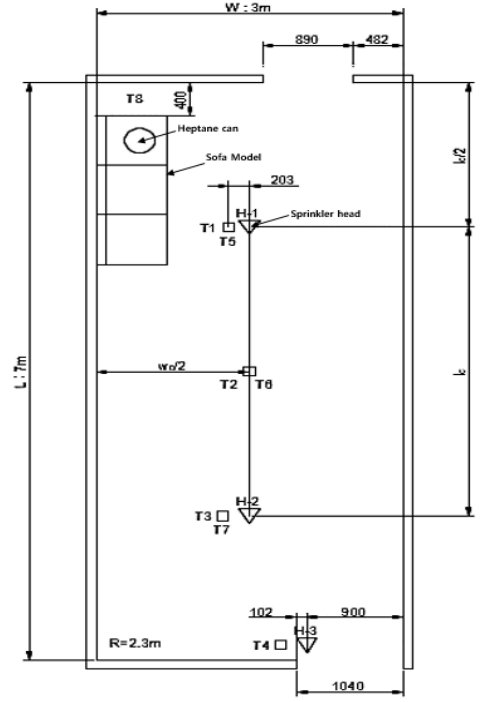
Figure 6. Schematic illustration of the fire test room and the thermocouple location. Note: T1–T4: Thermocouple 76 mm below the ceiling, T5–T7: Thermocouple 1600 mm above the floor, T8: Thermocouple 6 mm above the ceiling and 254 mm diagonally from the corner, H-1, 2, 3: Sprinkler head.